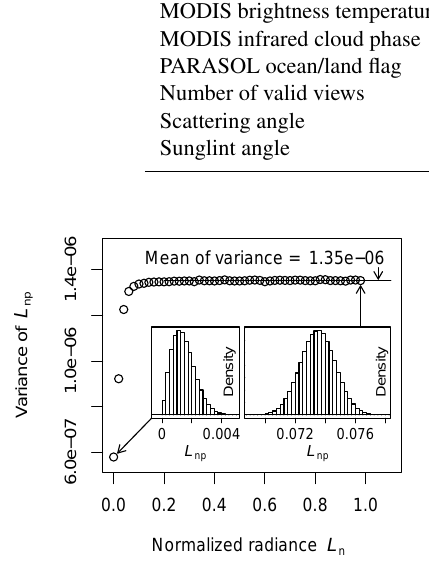
Figure 5. The simulated variance of L np as a function of L n . The variance of L np increases as the normalized radiance L n (bright- ness of a pixel) increases, becoming nearly constant at var (L np ) = 1 . 35 × 10 − 6 once L n reaches L n = 0 . 2. Insets show that the distri- bution of L np tends to a normal distribution, justifying the use of a normal distribution as an error distribution of L np for a reflective cloudy